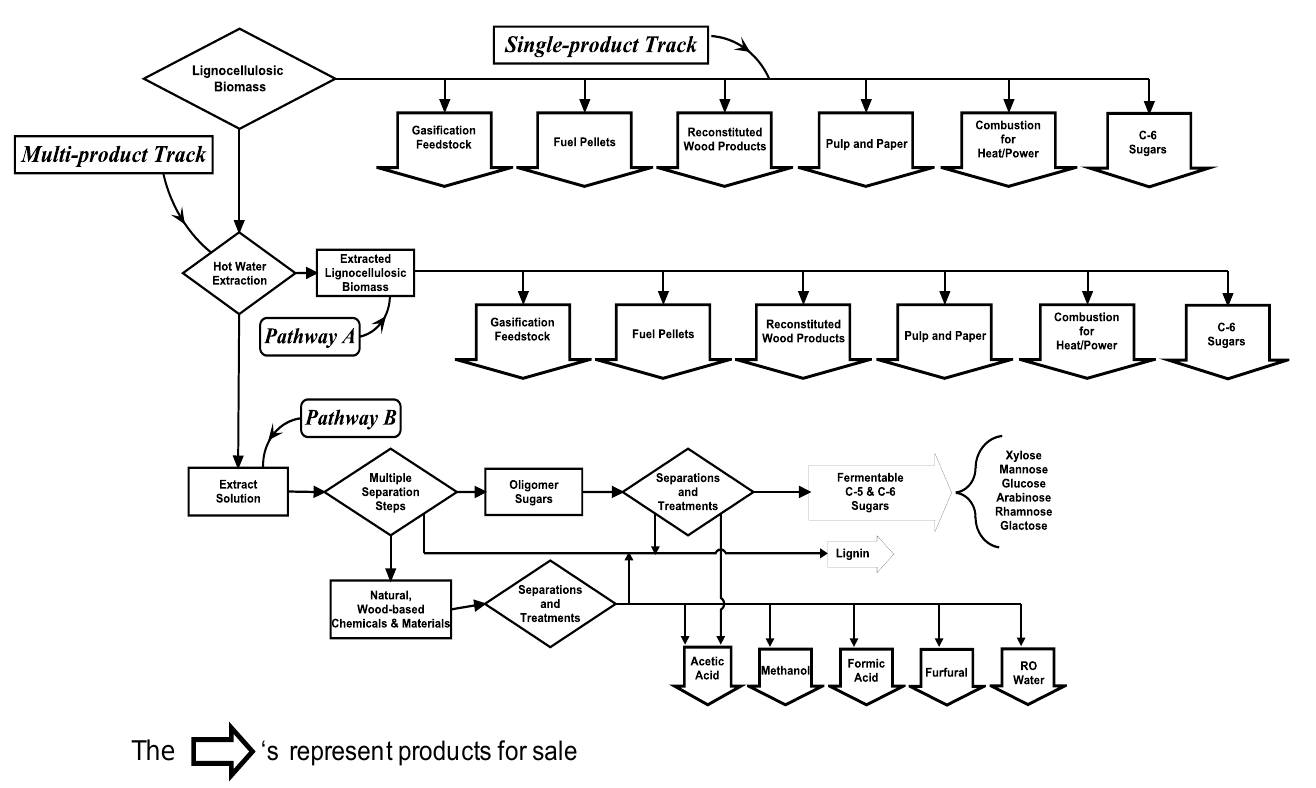
Figure 3. Contrasting, generalized Single-product and Multi-product biorefinery